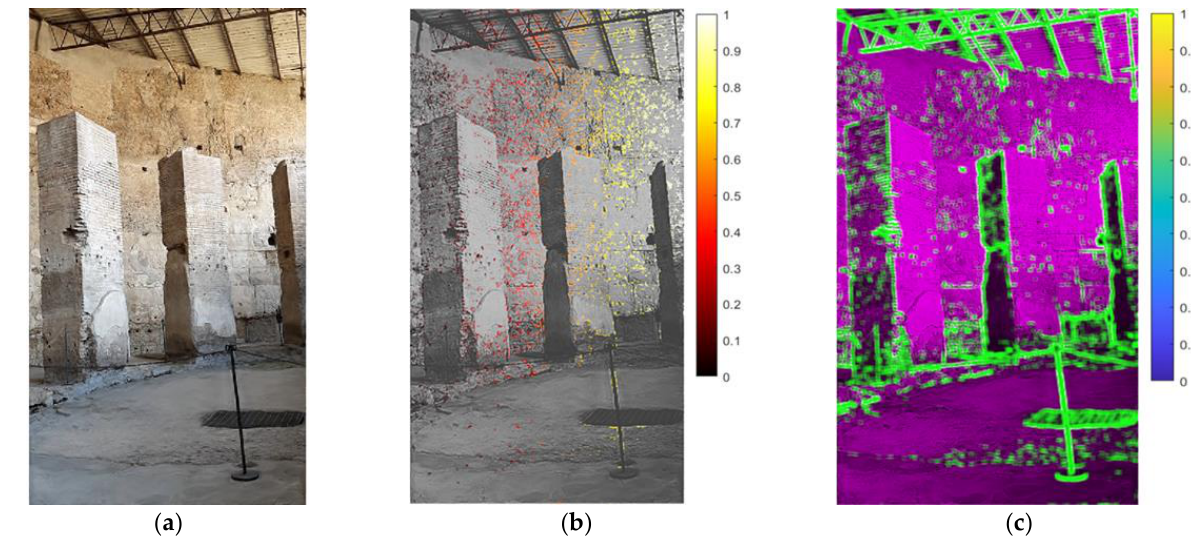
( b ) Figure 13. MM analysis of the 16th-century wall: ( a ) mapping of the max displacements of the wall in the frequency range 0.5 – 1.5 Hz; ( b ) theoretical modal shapes of a straight vertical cantilever.